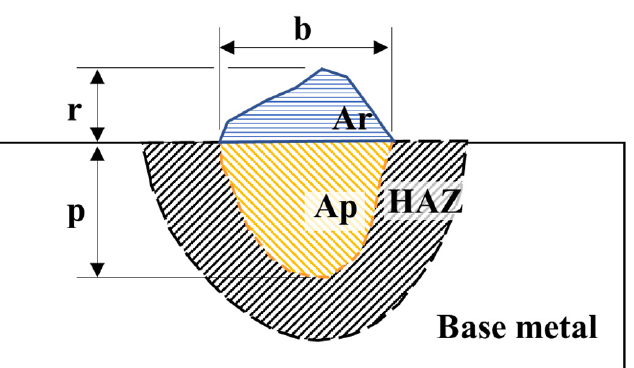
Figure 3. Schematic cross-section of the weld bead. Where: reinforcement height (r); bead width (b); penetration depth (p); reinforcement area (Ar); penetration area (Ap), and heat-affected zone (HAZ). and boundaries.